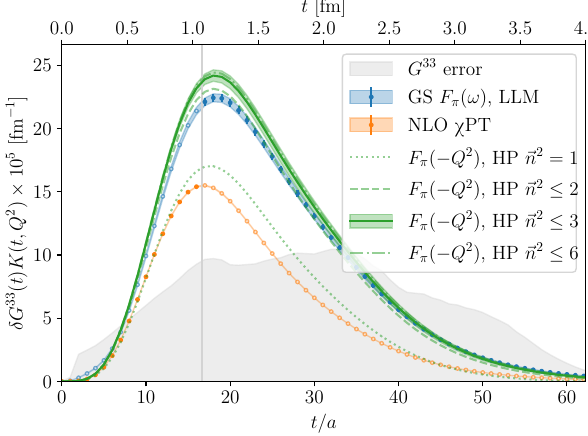
Figure 4 . Comparison of the TMR integral at Q 2 = 1 GeV 2 of the finite-size correction to the G 33 correlator on the D200 ensemble as a function of the TMR integration time. The MLL-GS method discussed in section 3.7.1 (blue points and band) agrees well with the HP method discussed in section 3.7.2 (green line and band), while the NLO q PT result using eq. (C.4) from ref. [63] (orange points and line) underestimates the finite-size correction except at very short time distances. The vertical gray line is at t i = ( m π L/ 4) 2 /m π . For comparison, the gray shaded area indicates the statistical error on the G 33